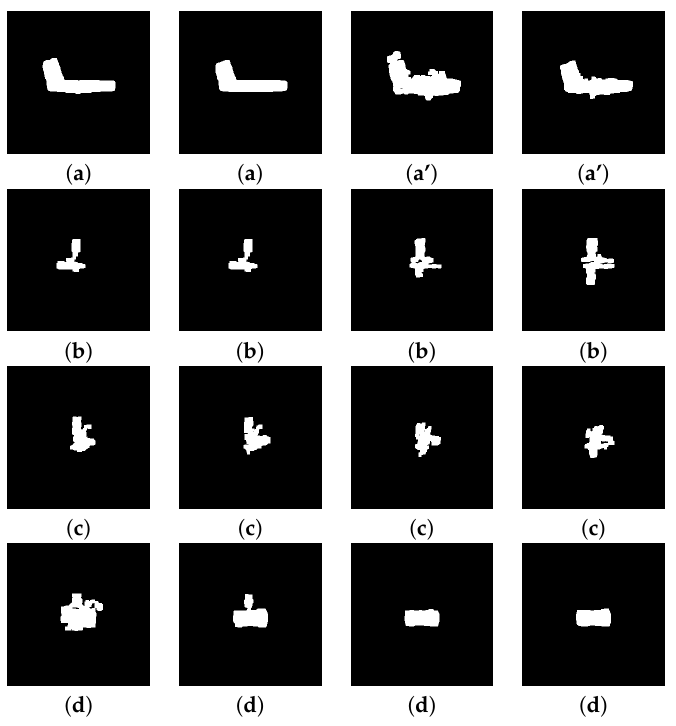
Figure 13. Segmentation of ‘V’ images, at frequency 94 GHz, with threshold parameter 0.87 and size 4 for the structuring element: ( a ) gun, ( a’ ) concealed gun, ( b ) knife, ( c ) keys, ( d )